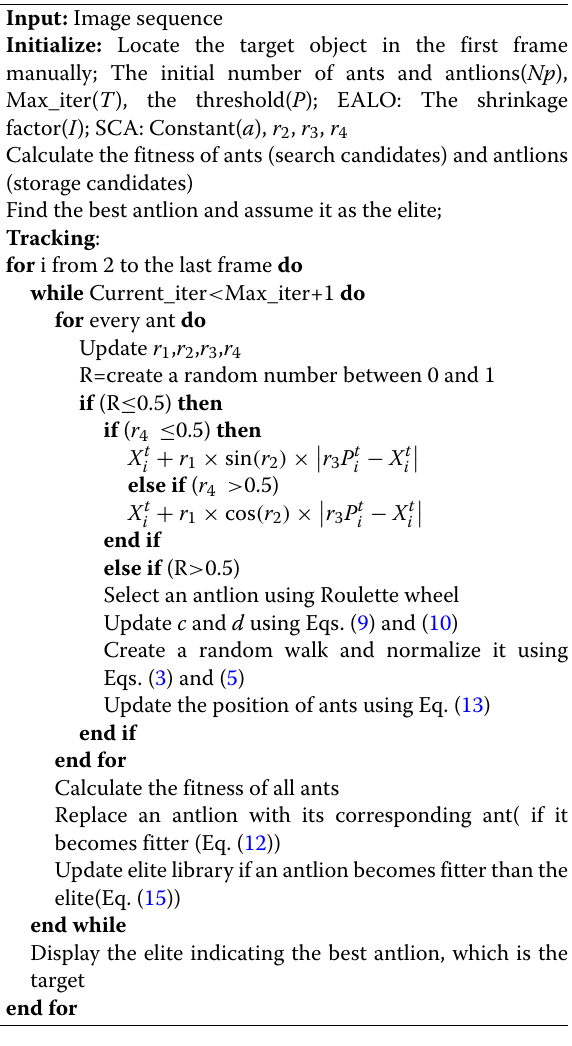
Algorithm 2 Pseudo-code of the EALO-SCA